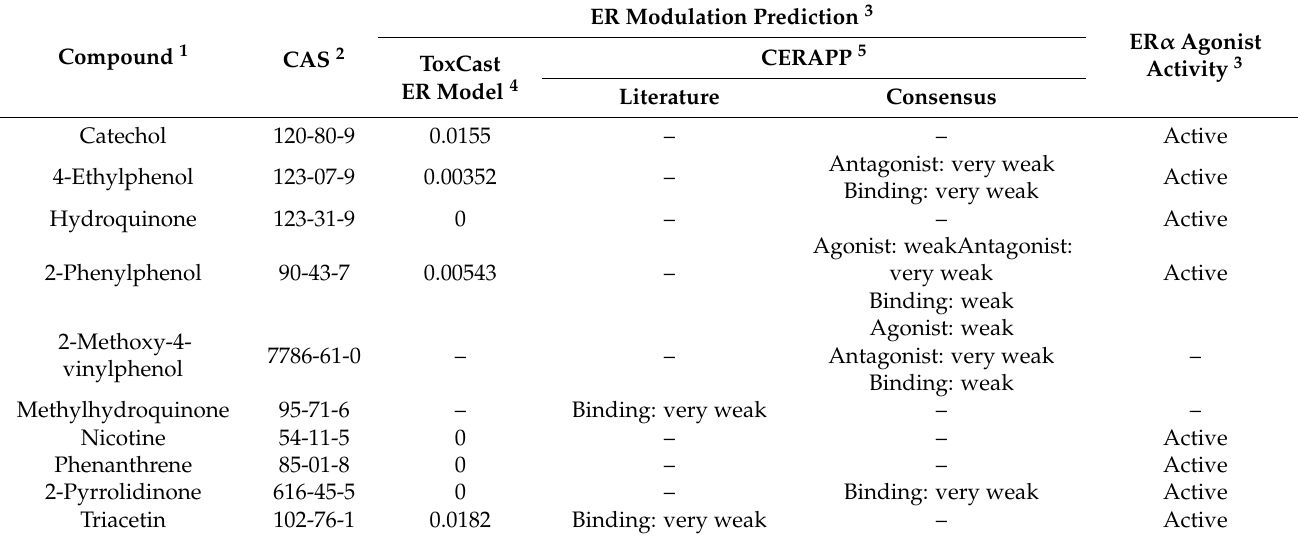
Table 2. Forecasting the ER-modulating potentials of putative organic components in cigarette sidestream smoke particulate